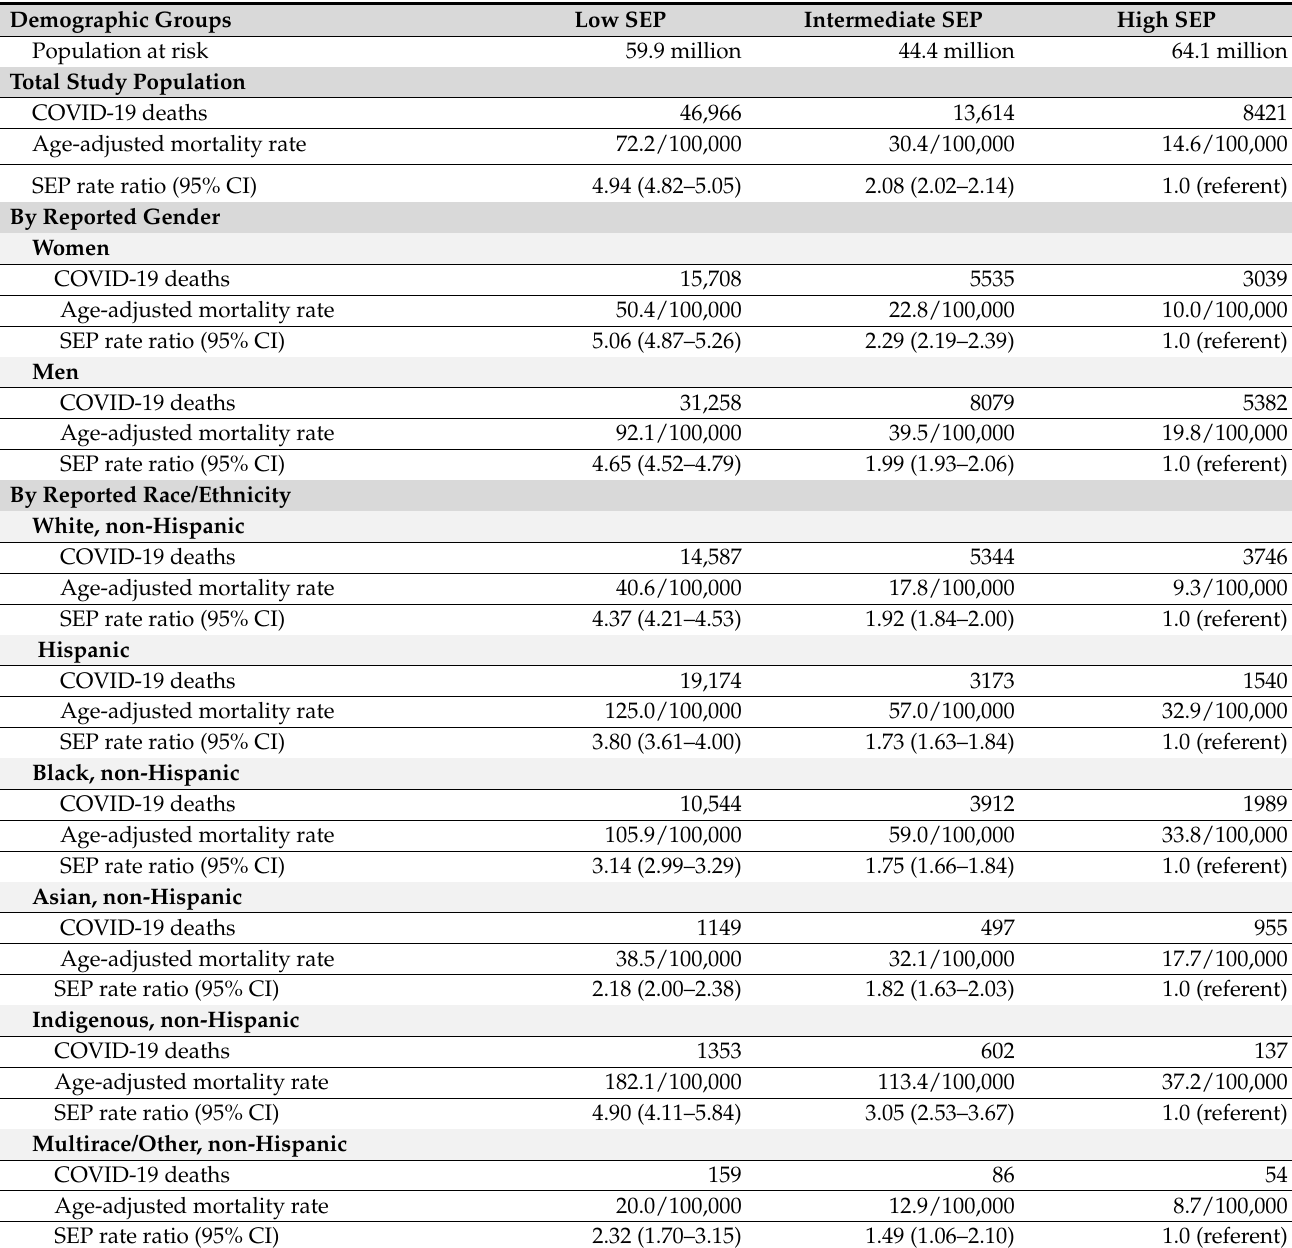
Table 1. Socioeconomic Position (SEP) Disparities in Reported COVID-19 Mortality Overall and by Gender and Race/Ethnicity among Adults 25–64 Years Old in the United States,